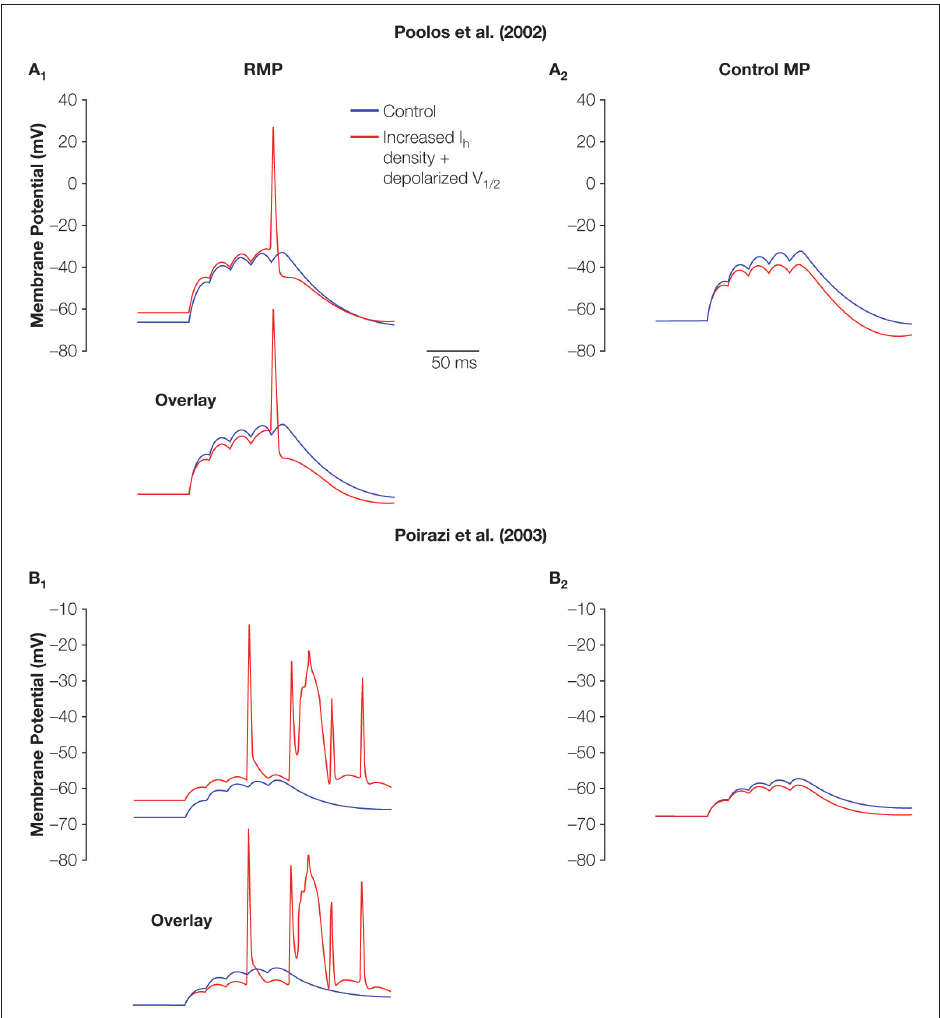
Figure 4 | Effect of increased I on summation and AP firing. The effect of five small EPSPs from the RMP (A1, B1) h and the common holding potential at control RMP (A2, B2) in two CA1 pyramidal neuron models ( A1, A2 , Poolos et al., 2002; B1, B2 , Poirazi et al., 2003) with control I (blue) and increased I density with depolarized V (red). Note that h h 1/2 the increased I leads to less summation, but firing of APs is abolished when the depolarization of the RMP is eliminated h by holding the cells at a common control